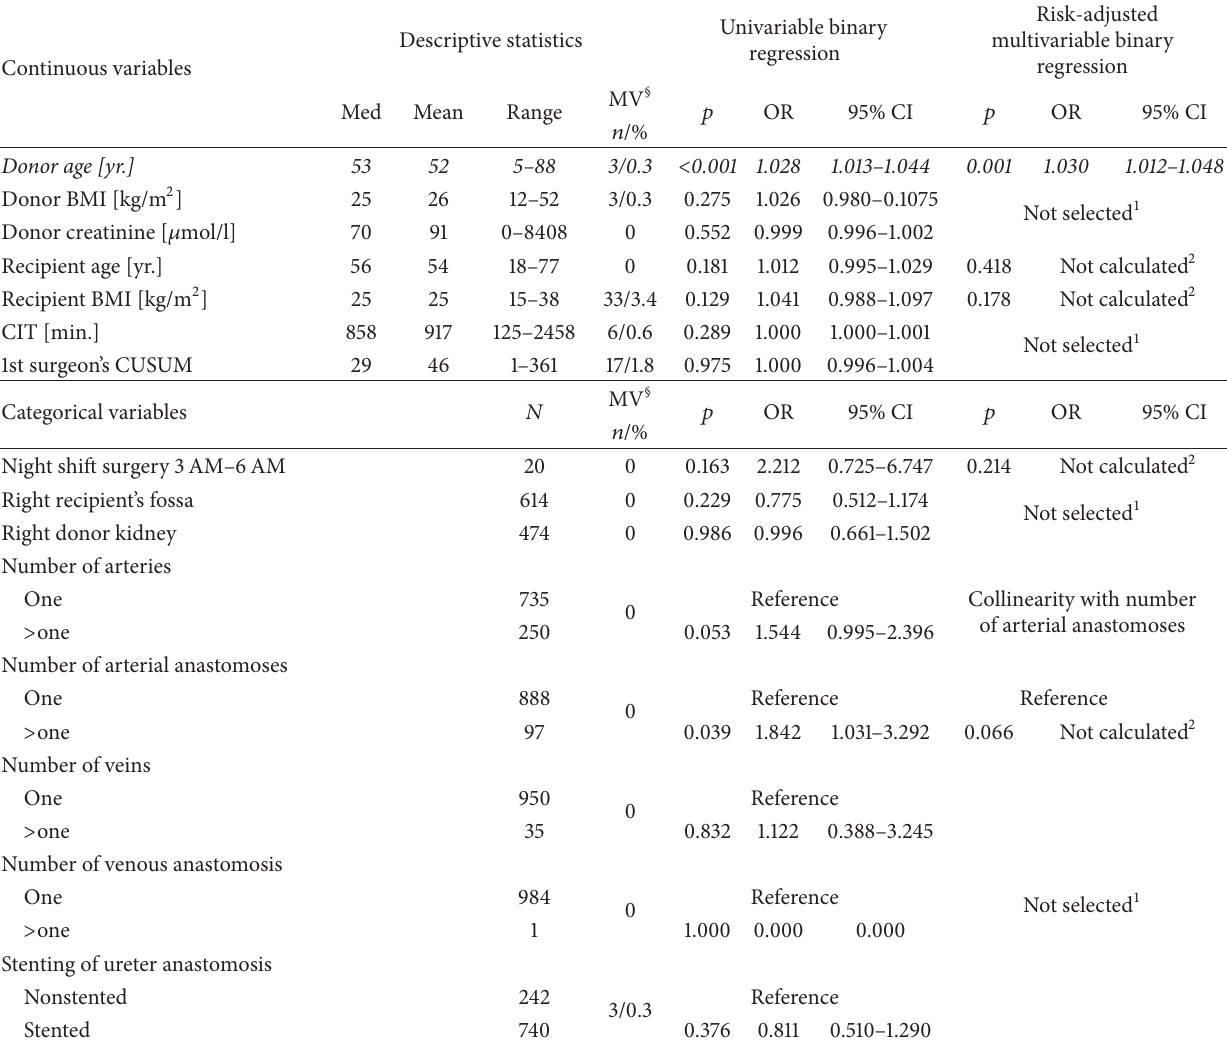
Table 7: Regression analysis of the risks for hospital discharge on dialysis ( 𝑛 = 102 ). Shown are the results of univariable and multivariable binary regression analyses to determine the odds ratios of the investigated variables for the risk of hospital discharge on dialysis ( 𝑛 = 102 ). Dialysis data were retrospectively available only for the period between 19 May 2003 and 31 Oct 2013. Analyzed were all cases ( 𝑛 = 985 ) with standard kidney transplantations into nonpreoperated sites. Included into risk-adjusted multivariable analyses were only transplant variables with a 𝑝 value ≤ 0.2 in univariable regression